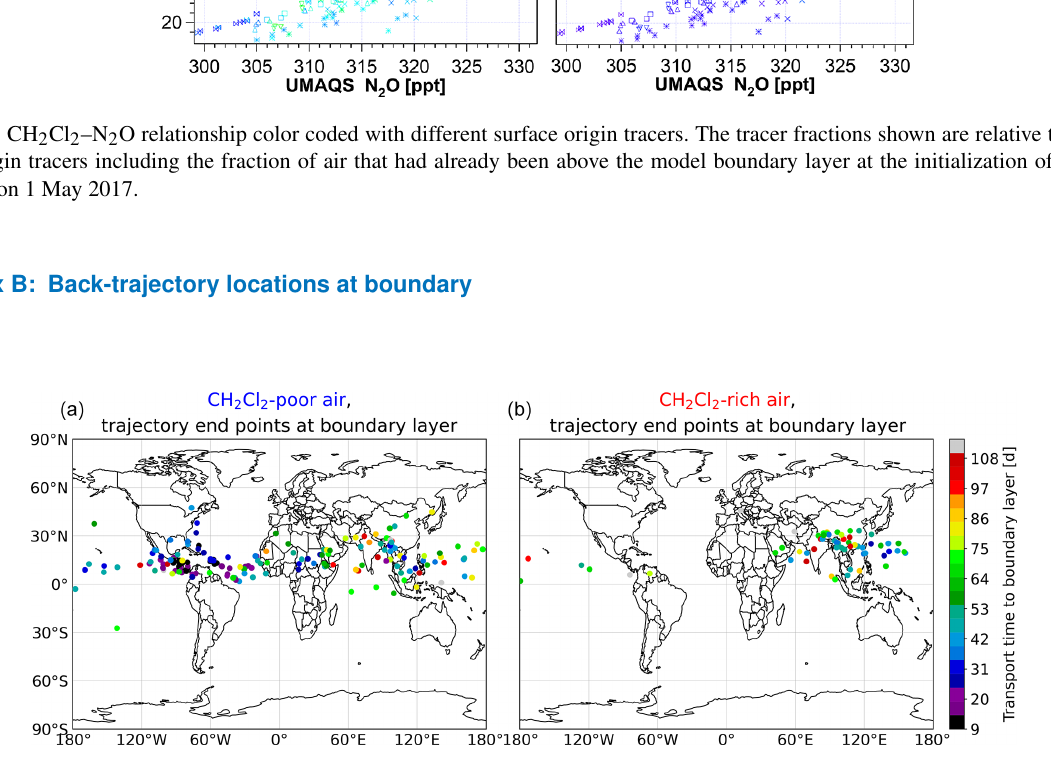
Figure B1. Location of back-trajectory end points at the model boundary layer, color coded with the transport time from the location of measurement to the location at the boundary layer. Shown are the locations at the boundary layer for CH 2 Cl 2 -poor (a) and CH 2 Cl 2 -rich air (b) from all WISE flights between 28 September and 21